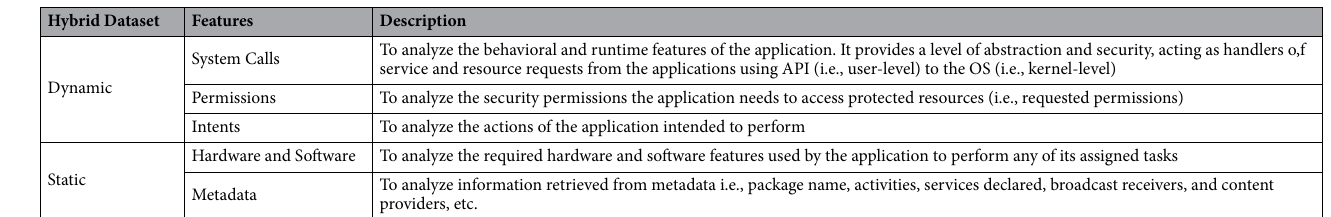
Table 3. Particularities of the used